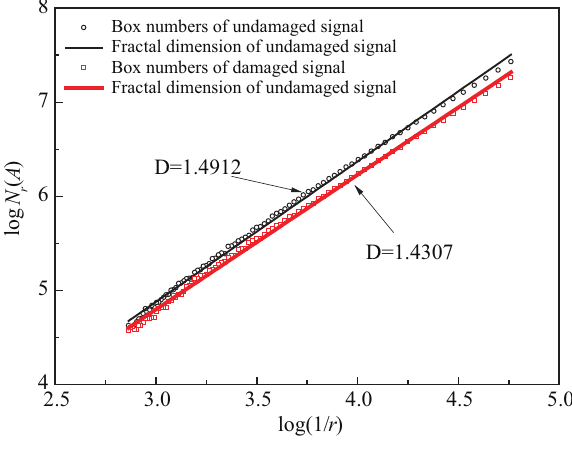
Fig. 2. Fractal dimension by least square fitting